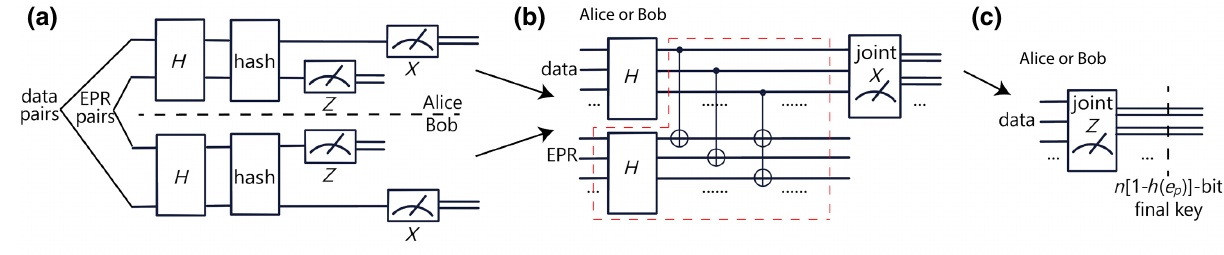
FIG. 8. (a) The reduced circuit from the phase-error-correction part in Fig. 1 by considering the following two facts: Hadamard+ Z - basis measurement = X -basis measurement; neither the identity nor the σ x gate affects the X -basis measurement. Now, Alice’s and Bob’s circuits become the same. (b) The reduction of Alice’s circuit: remove the measurement on the ancillary qubits since the results do not affect the measurement on data qubits; replace individual X -basis measurements with joint X -basis measurements on data qubits; and explicitly express the hash operation with the CNOT gates shown in Fig. 1(b) as an example. If the joint X -basis measurements commute with the hash operation, the circuit in the red dashed box does not affect the measurements and hence can be removed. (c) Further reduction of Alice’s circuit: remove the redundant circuit in the red dashed box and combine joint X -basis measurements with the Hadamard gates, which become joint Z -basis measurements. Finally, Alice can obtain an n [1 − h ( e p ) ]-bit secure key from the joint Z -basis measurements in a QKD